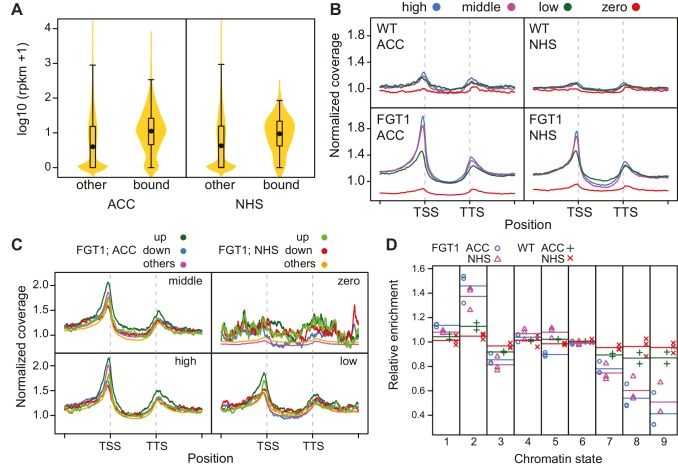
FGT1 globally binds expressed genes upstream of the TSS.(A) FGT1-associated genes (ChIP-seq peaks) are more highly expressed than other genes. Violin plot indicates expression levels of FGT1-bound genes compared to all other genes (Figure 4—figure supplement 1). Expression data were taken from (Gan et al., 2011). (B) Normalized global read coverages of ACC or NHS FGT1-YFP or wild-type control samples as determined by ChIP-seq. Genes were categorized into not expressed genes and equally sized groups of highly, moderately and lowly expressed genes (Gan et al., 2011). Coverage profiles include 2 kb up- and downstream of the TSS and TTS, respectively. Genic regions were normalized to a standard length. (C) Normalized read coverages of HS-responsive genes from ACC or NHS FGT1-YFP. The panels show global analysis of genes in the respective expression class (cf. B) according to their expression pattern 4 h after ACC (Stief et al., 2014) in wild type (up, down, others). (D) FGT1 is enriched in chromatin state 2 (Sequeira-Mendes et al., 2014). Relative enrichment of FGT1-bound sequences or WT control after ACC or NHS in different chromatin states indicated depletion of FGT1 in heterochromatin (states 8, 9) and enrichment in state 2 (promoter and intergenic regions, open chromatin). Lines denote average of replicates.